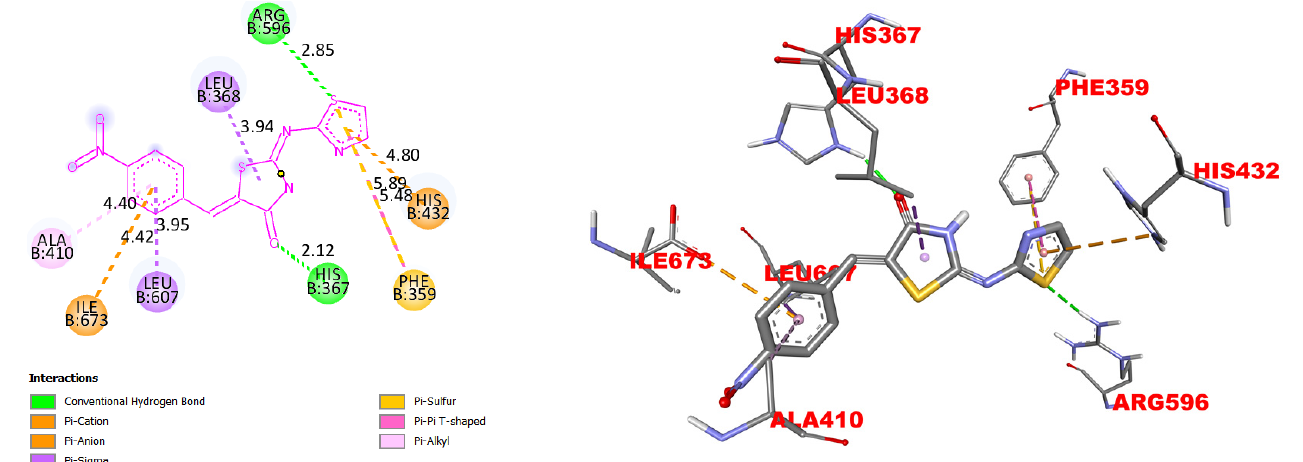
Figure 2. 2D and 3D binding mode of Les-6222 with 5-LOX.